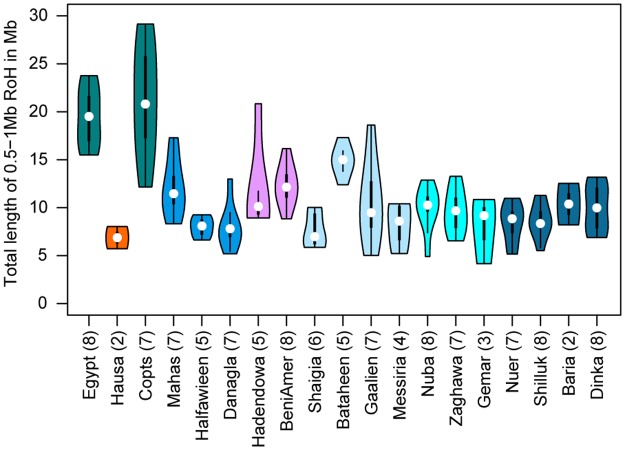
Distribution of total length of runs of homozygosity per individual per population.Runs of homozygosity are between 0.5–1 Megabases (Mb) in length. Runs of homozygosity were calculated on a chimeric dataset (SI).